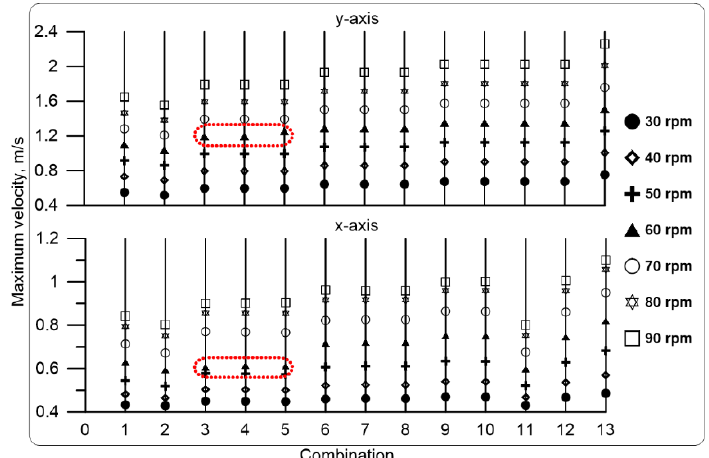
Figure 6. Maximum velocity values of the gripper for different length combinations and operating speeds.